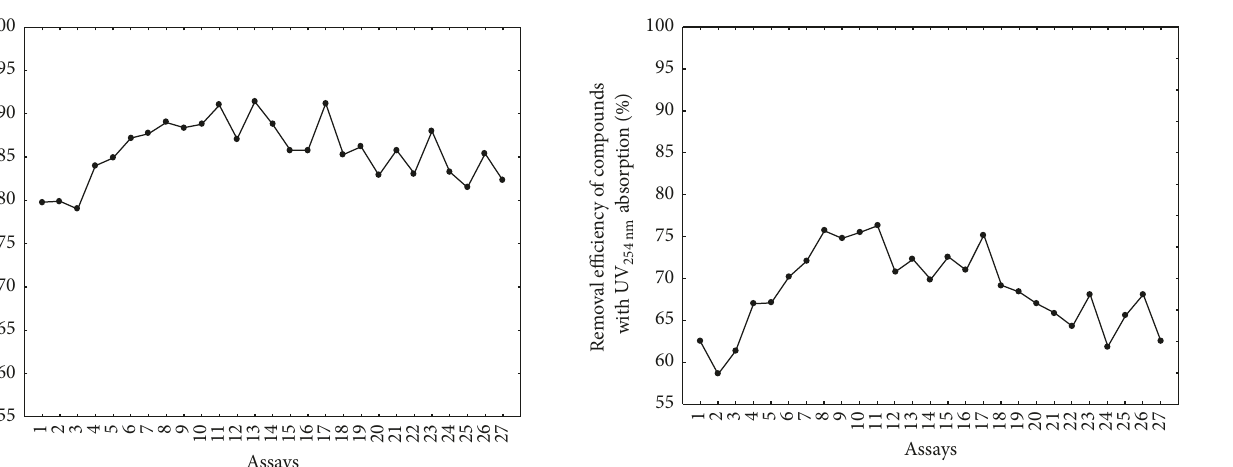
Figure 2: Removal efficiency of M. oleifera and aluminium sulphate for turbidity.